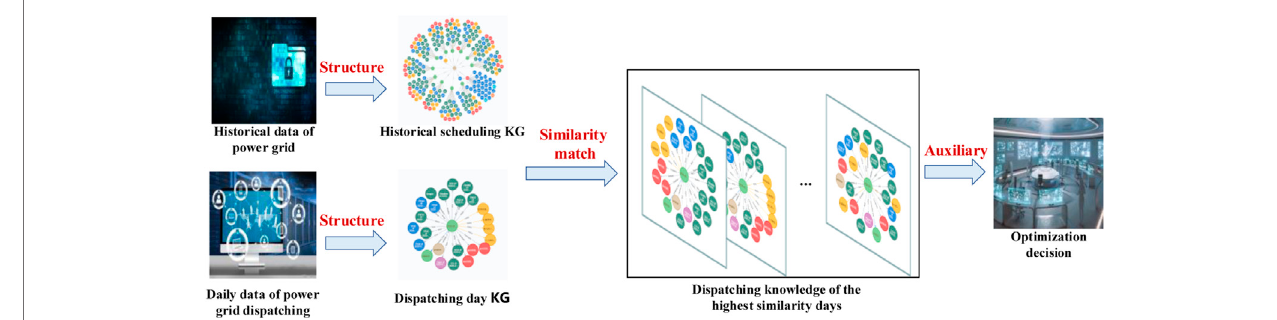
FIGURE 4 | Auxiliary optimization decision based on the knowledge graph.